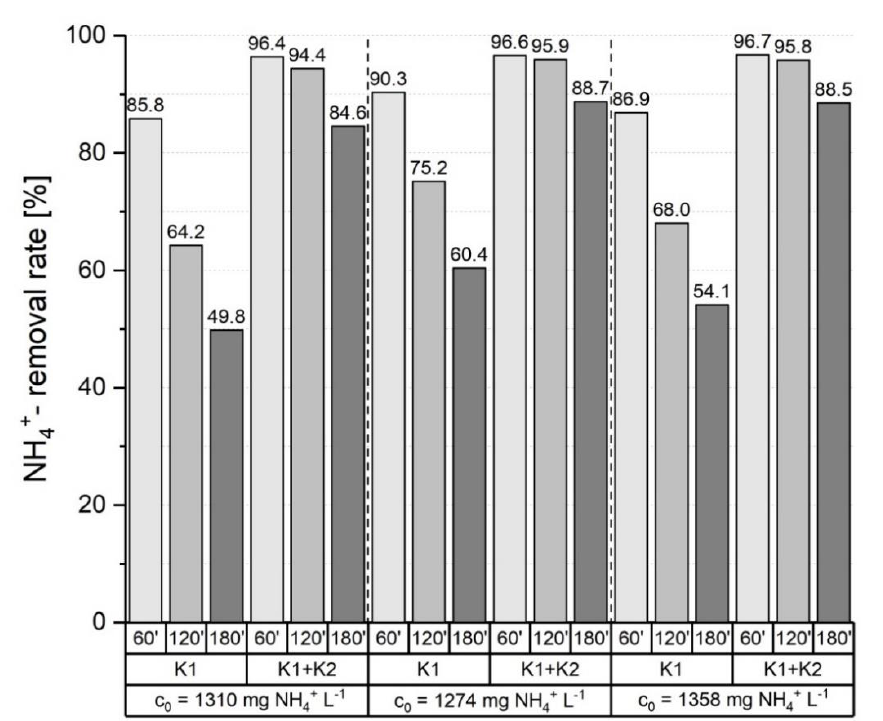
Figure 4. Ammonium removal rates (%) from and input concentrations c 0 after different operation times for single (K1) and serial column operation (K1 + K2) using flocked breeding manure.